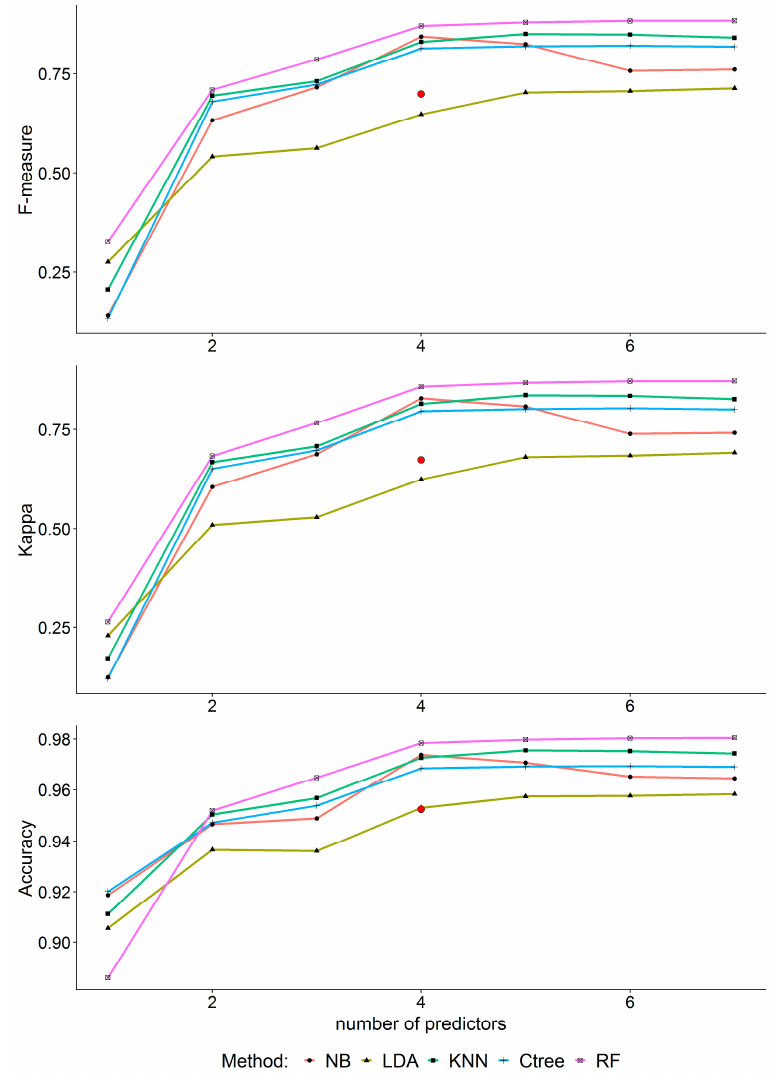
Figure 7. Performance of the machine ‐ learning classification methods with different numbers of features. Each point is produced by taking the mean value of 200 repetitions of stratified cross validation performed on the Fürstenzell dataset. The red point represents the performance of the Bu_15 method with four parameters.